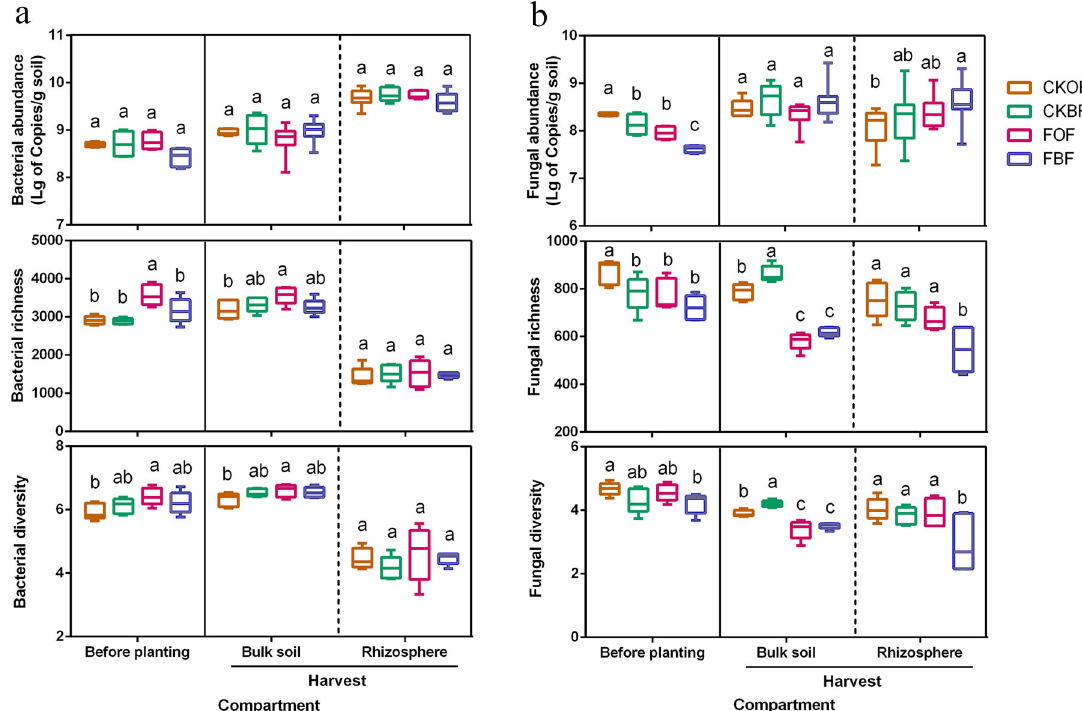
Fig. 3 Boxplot of abundance, richness (sobs), and diversity (Shannon) index. a bacterial community; b fungal community. CKOF: organic fertilizer was amended in un-fumigated soil; CKBF: bio-organic fertilizer was amended in un-fumigated soil; FOF: organic fertilizer was amended in fumigated soil; FBF: bio-organic fertilizer was amended in fumigated soil. Different letters indicate signi fi cant differences among the four treatments as de fi ned by Tukey ’ s test ( p <